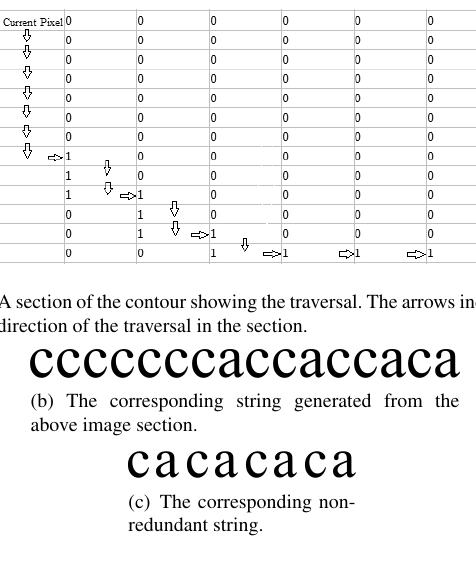
Figure 11. The final string generation.